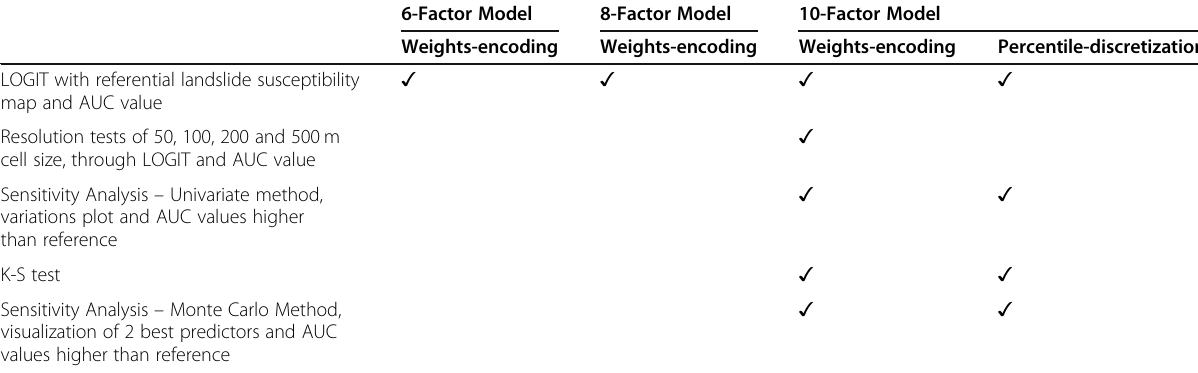
Table 5 Methodology summary and applied